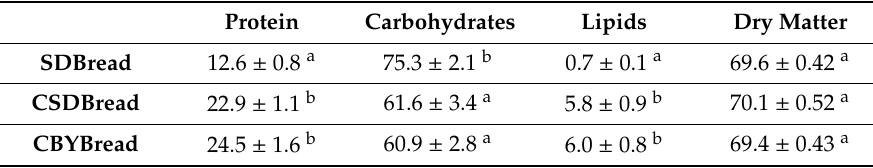
Table 3. Approximate chemical composition of breads (g/100 g).